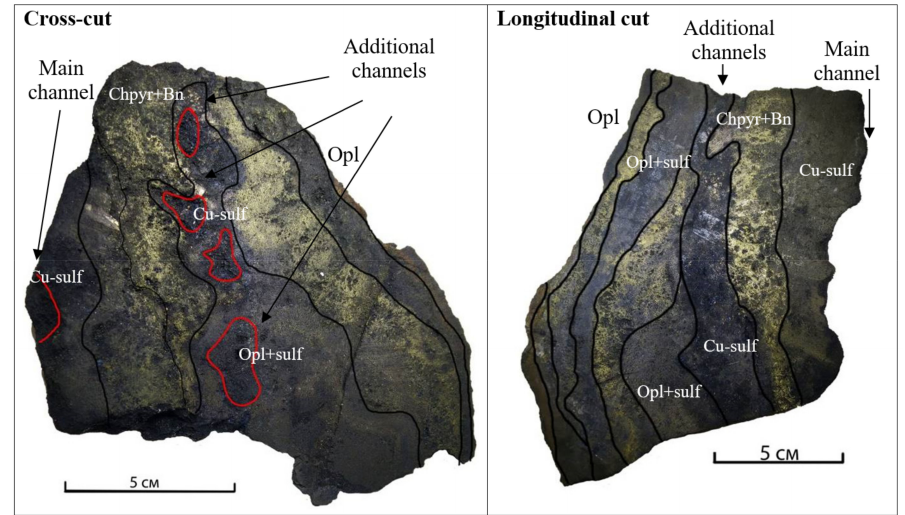
Figure 9. A fragment of a chimney wall. On the left —a cross-cut, on the right —a longitudinal cut. Opl: opal; Chpyr: chalcopyrite; Bn: bornite; Cu-sulf: non-stoichiometric copper sulfides. Field Molodezhnoye.